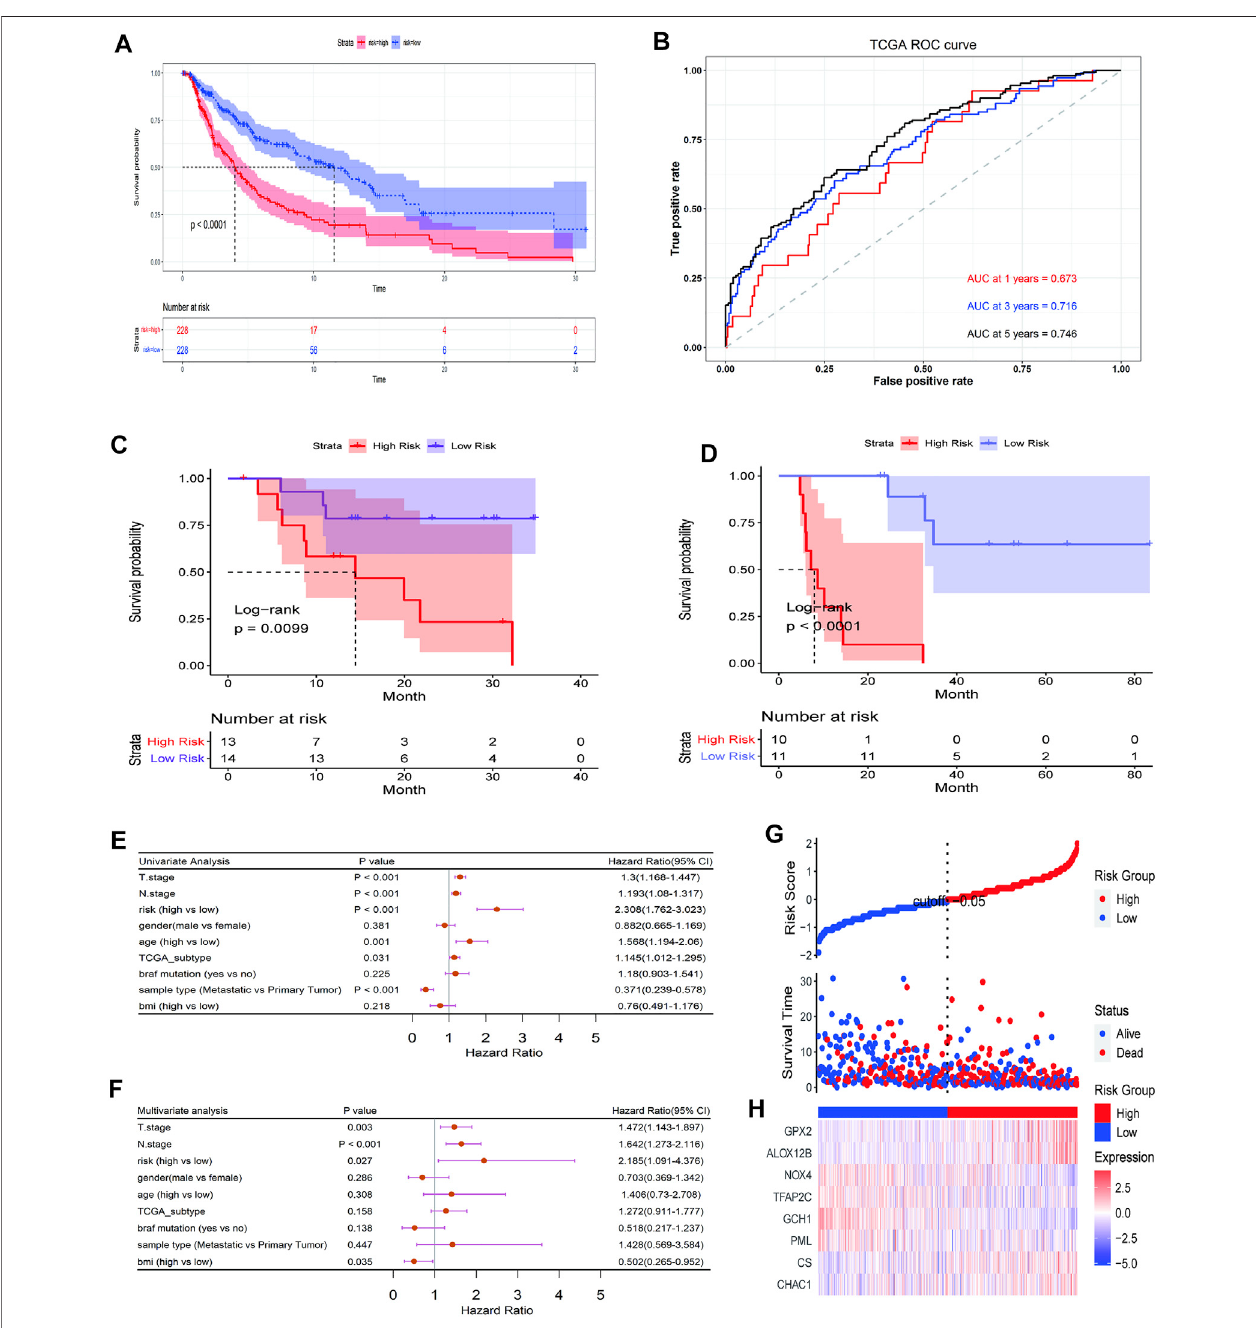
FIGURE 3 | Prognostic signi fi cance of the ferroptosis-related gene signature derived risk scores in TGGA cohort. (A) Kaplan-Meier analysis of melanoma patients wasstrati fi ed by median riskscore in TCGA cohort. (B) Receiver operating characteristic (ROC) curve ofrisk score signature. (C, D) Kaplan-Meier analysis ofmelanoma patients was strati fi ed by median risk score in GSE78220 cohort (C) and MSKCC cohort (D) . (E, F) Univariate and multivariate Cox regression analysis showed the predictive utility of the risk-score signature possesses excellent prognostic independence. (G) The curve shows the distribution of patient risk scores, survival status, and survival time. (H) Heatmap shows the expression of each gene in the risk-score signature.